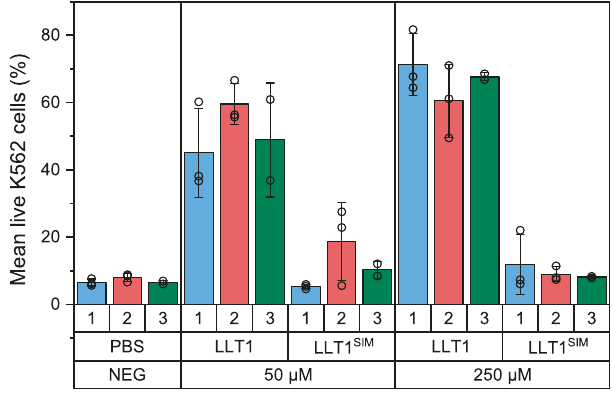
Fig. 7 | Inhibitory effect of soluble LLT1 on the NK cell-mediated cytotoxicity. NK cells from three different donors (blue, red, and green) and K562 target cells were incubated with PBS buffer only (negative control) or with the soluble LLT1 or LLT1 SIM proteins,bothin50and250 µ Mconcentrationscorrespondingtothe1×and 5×K D values,respectively,asanalyzedbytheAUCfortheprimaryinteractionmode (cf.SupplementaryFig.4).BarchartsrepresentthemeansofliveK562cellsineach condition with results of individual experiments plotted as empty circles, and the whiskers represent ±SD. When applicable, data were statistically evaluated by one- wayANOVA.Considering p <0.05asstatisticallysigni fi cant,theinhibitoryeffectof soluble LLT1 signi fi cantly differs from LLT1 SIM , which does not differ from the control condition lacking any NKR-P1 ligand. Source data are provided as a Source Data fi